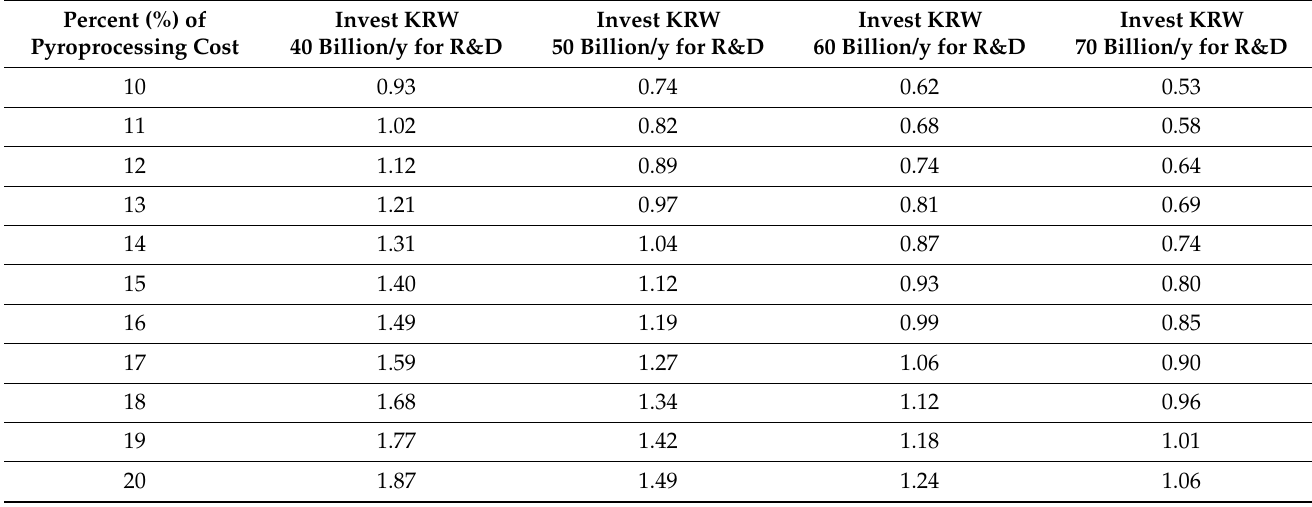
Table 11. Pyroprocessing benefit/cost